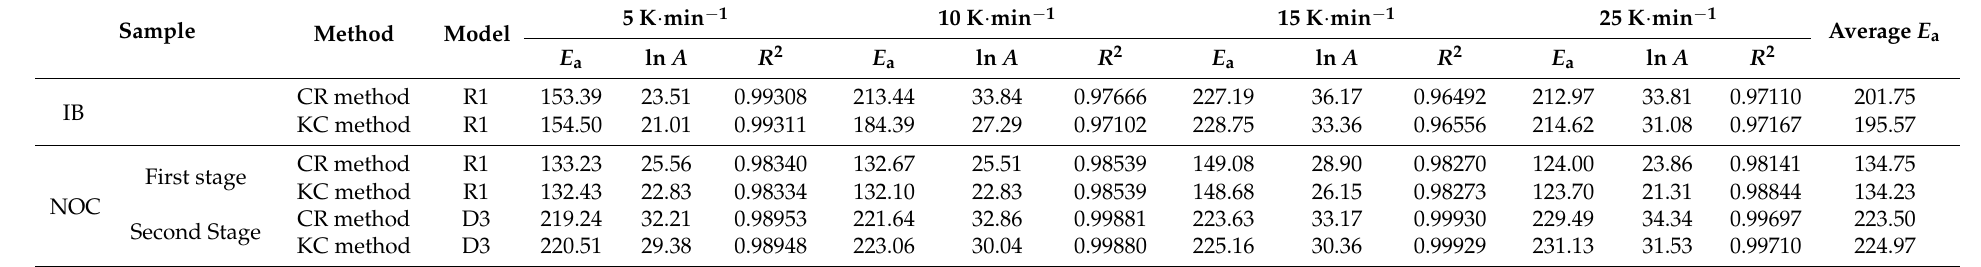
Table 4. The kinetic parameters of IB and NOC calculated by Coats-Redfern and Kennedy-Clark methods for the best models which describe the pyrolysis process well at different heating